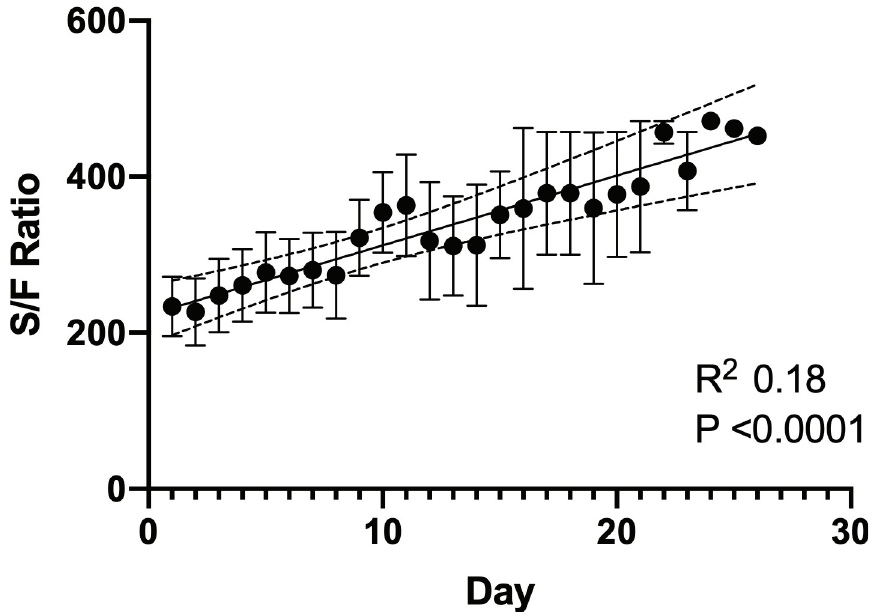
Fig 4. Linear regression of S/F ratio for all patients that completed a minimum of 7 days of losartan in the prospective cohort from the start of losartan during hospitalization until the time of discharge or discontinuation of losartan. Data expressed as mean ± SEM of S/F ratio for each day, with best fit line (R 2 , slope with 95% confidence interval, P-value for statistically significant non-zero slope).